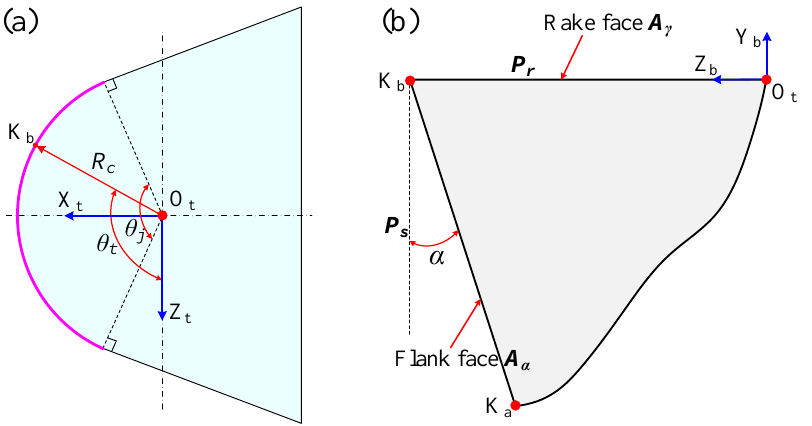
Figure 13. Illustration of tool geometry on two planes: ( a ) X t Z t plane; ( b ) Y b Z b plane. The detailed expression of line K b K a in Y b Z b rectangular coordinates can be seen in Figure 14. K ab is the point on the line K b K a that corresponds to the profile of flank face. The distance from point K ab to vertex K b is set to u . The coordinate values of the K ab point, corresponding to the Y b and Z b axis, are − ucos α and R c − usin α , respectively. Therefore, the profile line K b K a can be expressed by the given variable u : b X ( )=0 u b Y ( ) u ucosα Figure 14. The detailed expression of line K b K a in Y b Z b rectangular coordinates. Considering the angle θ t , the equation of tool geometry in the tool coordinate system can be expressed through a vector group [X t ( u , θ t ), Y t ( u , θ t ), Z t ( u , θ t ), 1] T by the following: t X ( ,